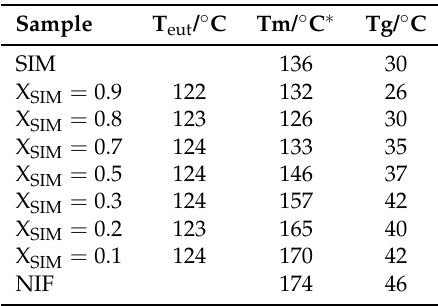
Table 2. Experimental values for the eutectic (T eut ), liquidus temperature (Tm) and glass transition temperatures (Tg) for the pure components (SIM, NIF) and the binary systems. Molar fractions are reported in terms of